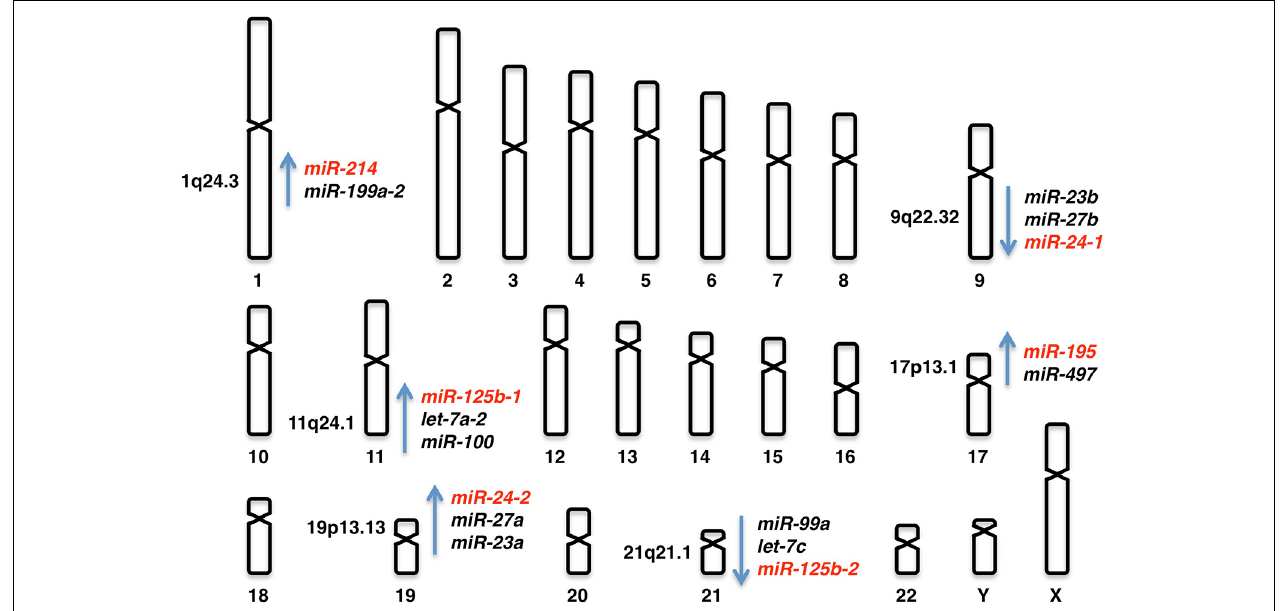
FIGURE 2 | Human chromosomal loci of miR-24-1 , miR-24-2 , miR-125b-1 , miR-125b-2 , miR-195 , and miR-214 .